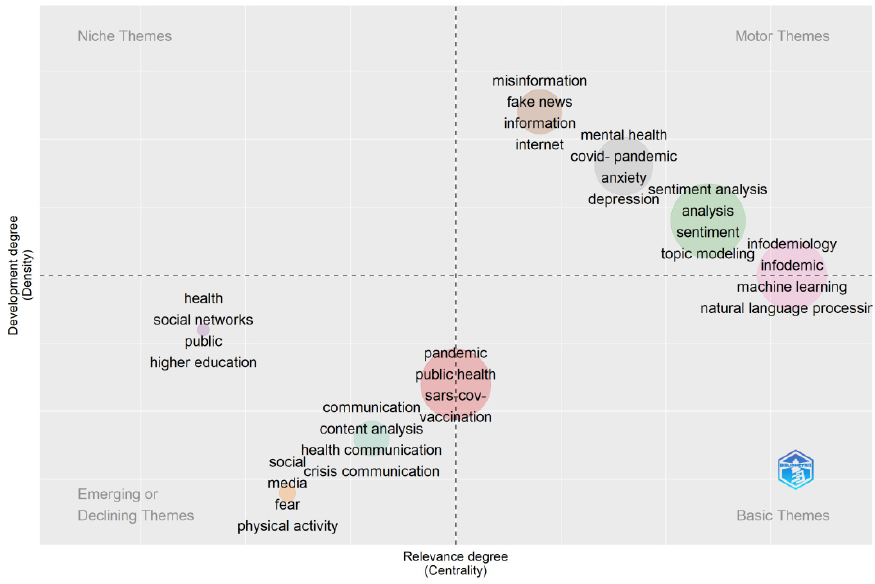
Figure 5. Thematic map of authors' keywords (this map was generated by Biblioshiny).